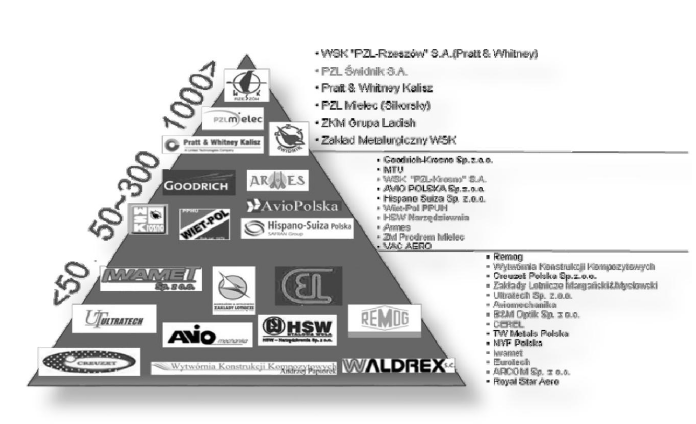
Figure 2: The structure of the Aviation Valley (Dolina Lotnicza) cluster in